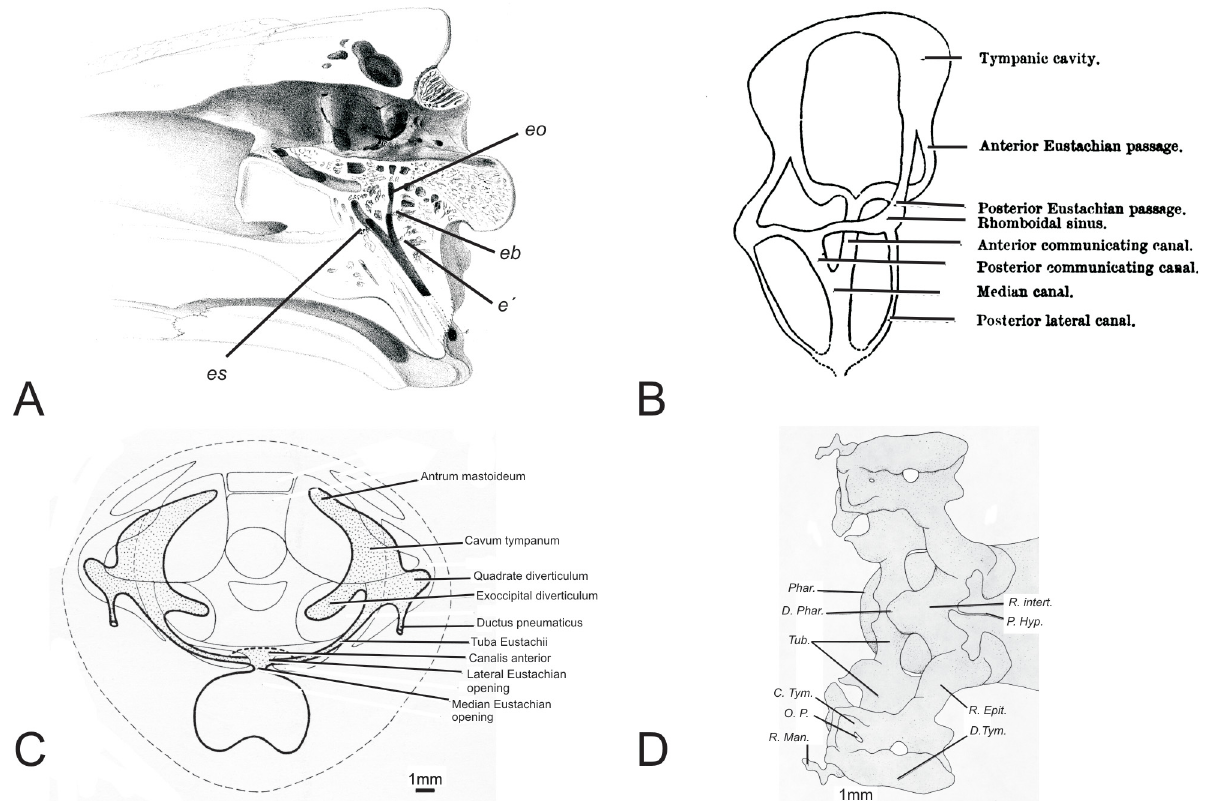
Fig 2. Previous representations of the crocodilian middle-ear space shown as A) a lithographic rendering of a parasagittal cut through the skull of a crocodile, adapted from Owen, 1850; B) a schematic depiction of the communicating canals of the tympanic cavity in rostral oblique view, adapted from Miall, 1878; C) a schematic showing the development of the tympanic cavity in a late stage embryo of Crocodilus cataphractus in rostrocaudal aspect, adapted from Müller, 1967; D) A schematic of the development of the tympanic cavity in a late stage embryo of Alligator mississippiensis in dorsal view, adapted from Simonetta, 1956. C. Tym., Tympanic cavity; D. Phar., Posterior pharyngeal diverticulum; D. Tym., Tympanic diverticulum; e ’ , bifurcation of the median Eustachian canal; eb, bifurcation of the basioccipital branch, eo, basioccipital branch of the Eustachian canal; es, basisphenoidal branch of the Eustachian canal; O.P., paratympanic organ; Phar., Pharynx; P. Hyp., Hypophyseal pedicle; R. Epit., epitubaric recess; R. Intert., intertympanic recess; R. Man., mandibular recess; Tub., Eustachian tube.